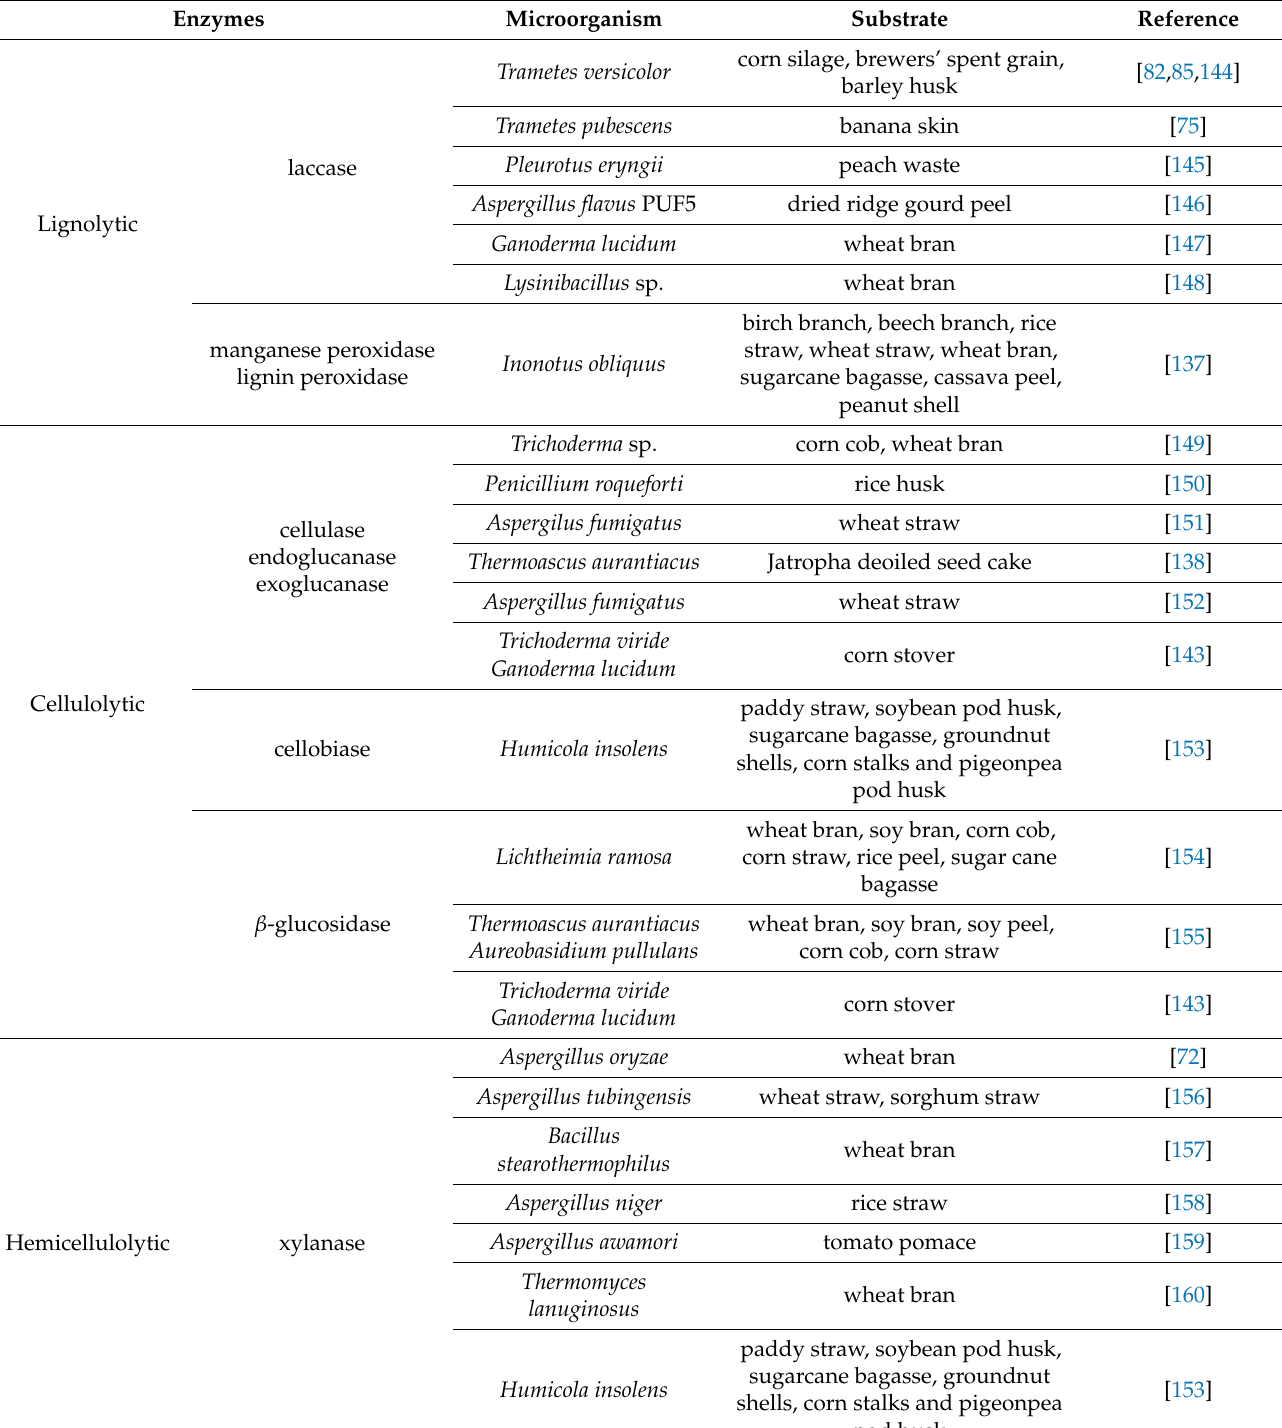
Table 6. Valorization of different AFIRs for the production of enzymes from different